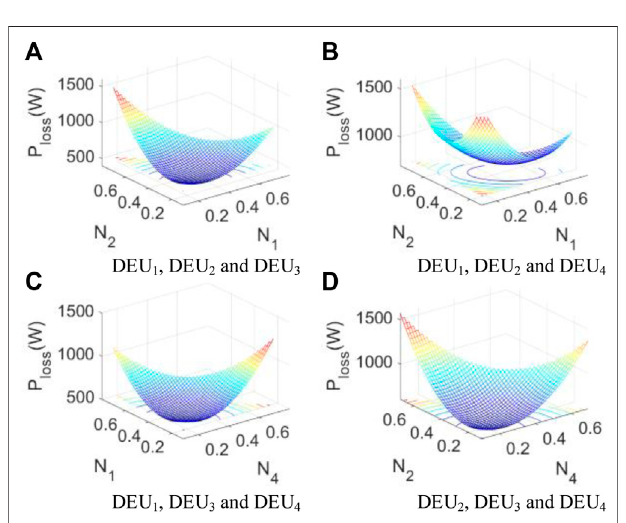
FIGURE 7 | Distribution loss with respect to current coef fi cients for fi xed (A)